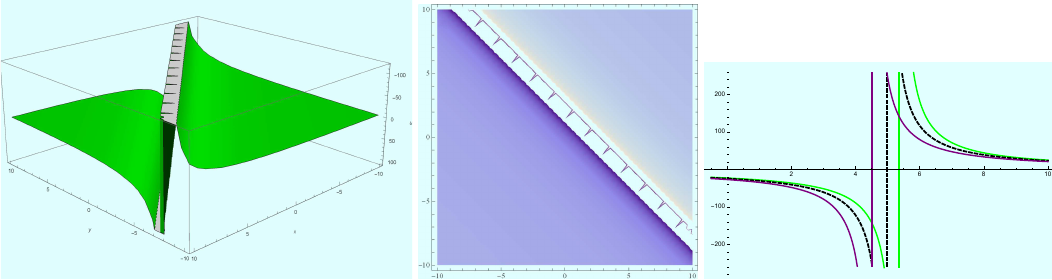
Figure 7. Evolution of traveling wave of singular soliton solution (25) at t = 2.1 and z = −